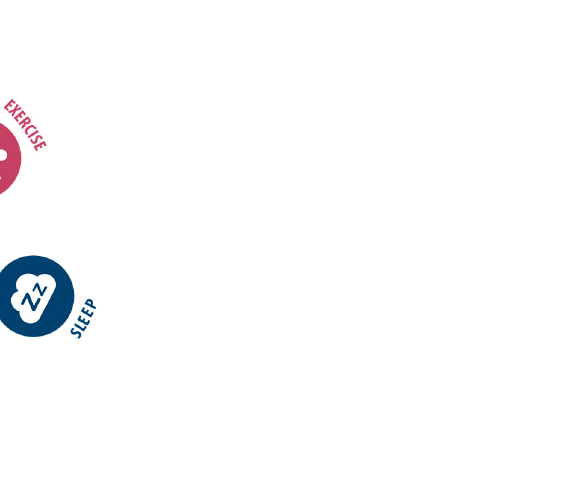
Figure 1. Identifying and addressing potential contributors to cognitive decline with a personalized, multi-therapeutic approach is supportive of cognitive health. Shown in the figure are the various core strategies for the reversal of AD and MCI and for optimizing brain health. This article systematically reviews clinical trials and observational studies that have incorporated multiple strategies to target numerous factors simultaneously to reverse, prevent, or treat cognitive decline and